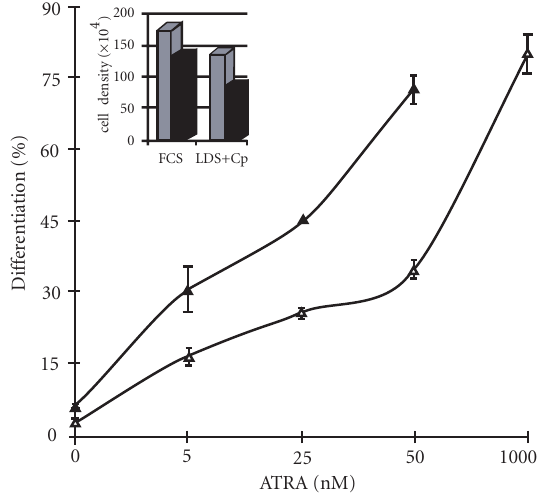
Figure 1: Effect of ATRA on HL-60 cell differentiation. HL-60 cells wereincubatedfor24hoursinfoetalcalf lipoproteindeprivedserum (LDS medium) supplemented with compactin (2 µ M). Then, they werewashedinphosphatebufferedsalineandculturedduring5days in LDS medium containing increasing concentrations of ATRA ( (cid:1)